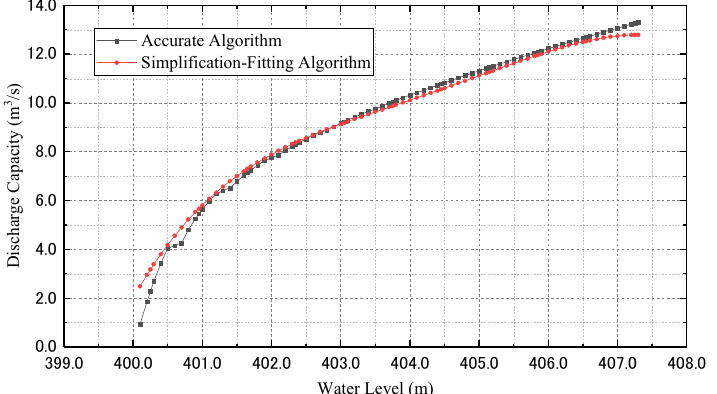
Figure 7. Figure on discharge capacity results from both simplified and accurate algorithms in the half-pressure flow stage.